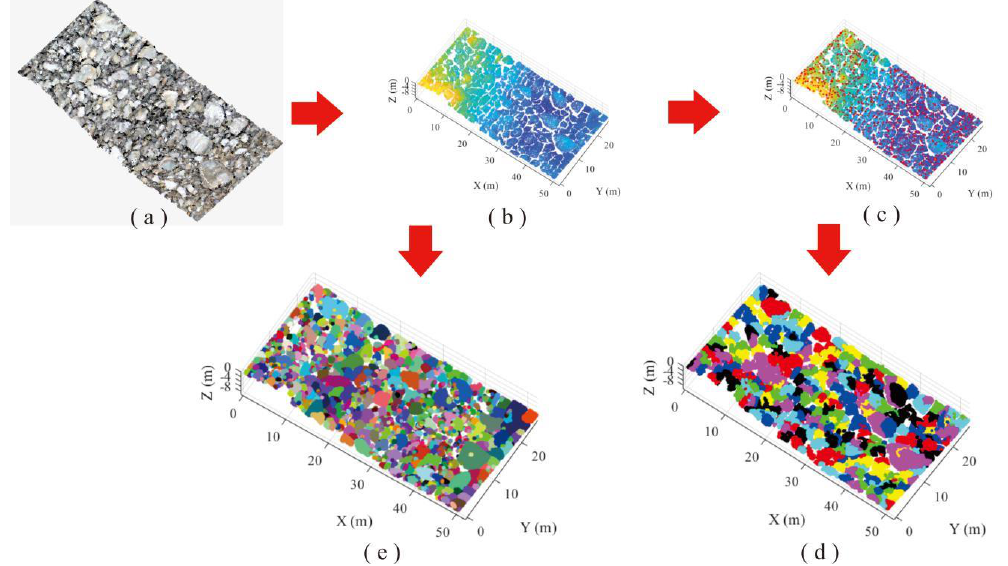
Table 2. Comparison of distribution characteristic parameters among upper and lower part of landslide deposit.